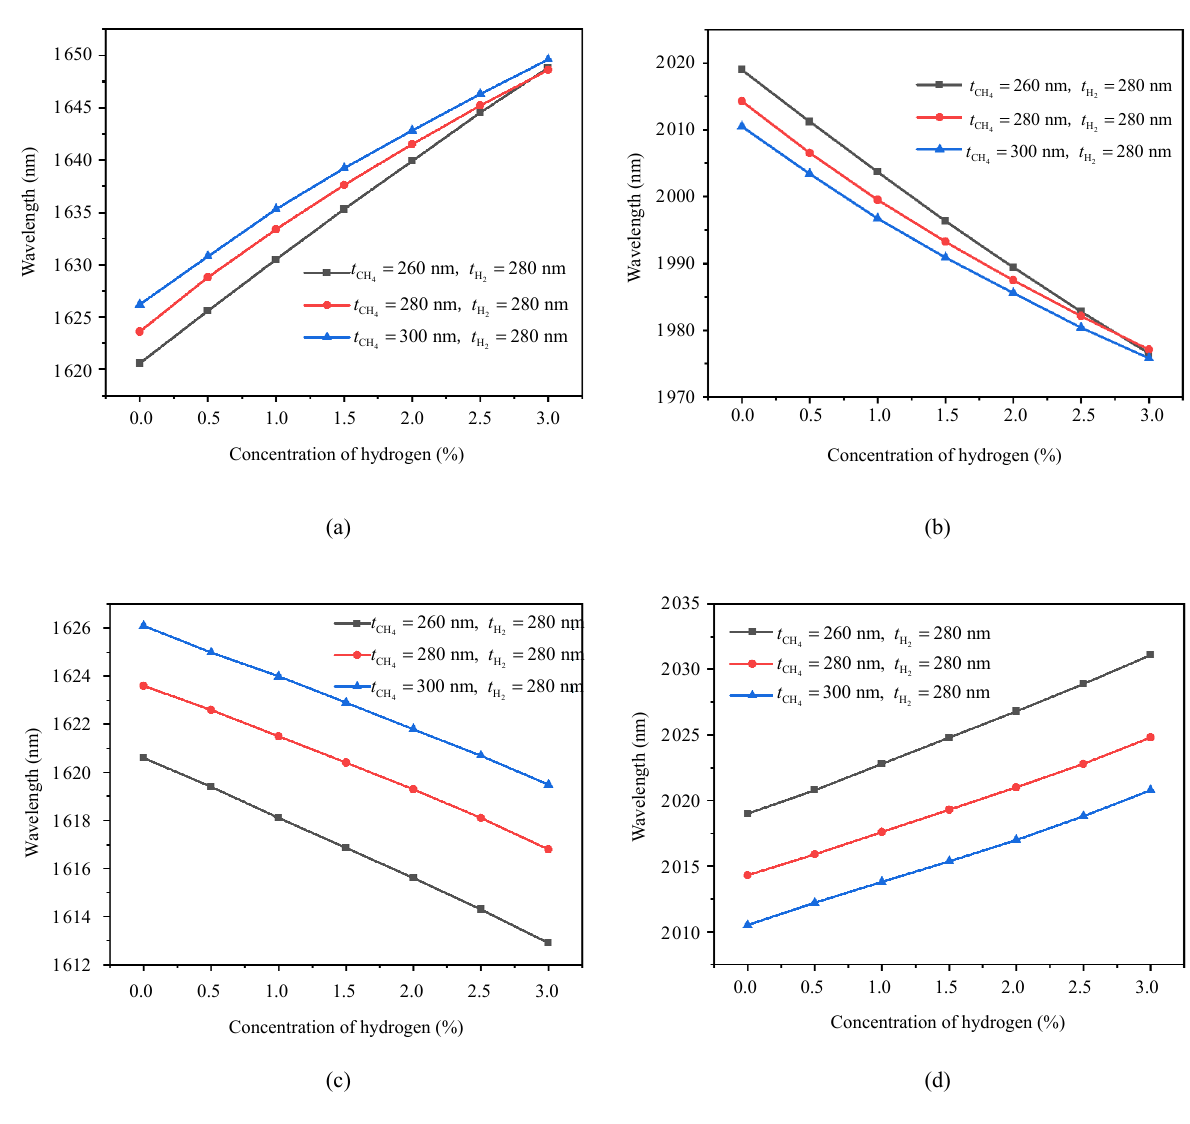
Fig. 6 Anti-Stokes peak wavelength shift curves (a) and Stokes peak wavelength shift curves (b) with the variation of the hydrogen concentration; anti-Stokes peak wavelength shift curves (c) and Stokes peak wavelength shift curves (d) with the variation of the methane